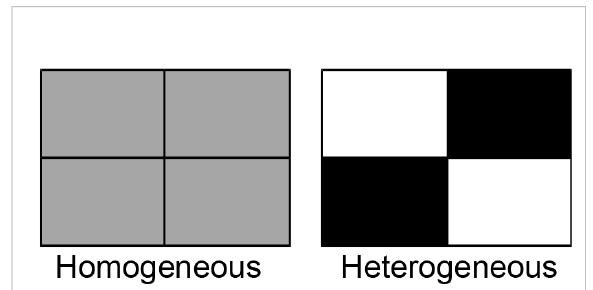
FIGURE 1 Schematic representation of the experimental design. For each of the six types of microplastics, we established a homogeneous and a heterogeneous soil treatment. For the homogeneous treatment, each of the four equal patches in a box was fi lled with the soil uniformly mixed with a low concentration (0.1%) of microplastics (grey); for the heterogeneous treatment, two opposite patches in a box were fi lled with the soil without microplastics (white) and the other two with the soil uniformly mixed with a higher concentration (0.2%) of microplastics (black). The total amounts of microplastics in the homogeneous and heterogeneous treatments were the